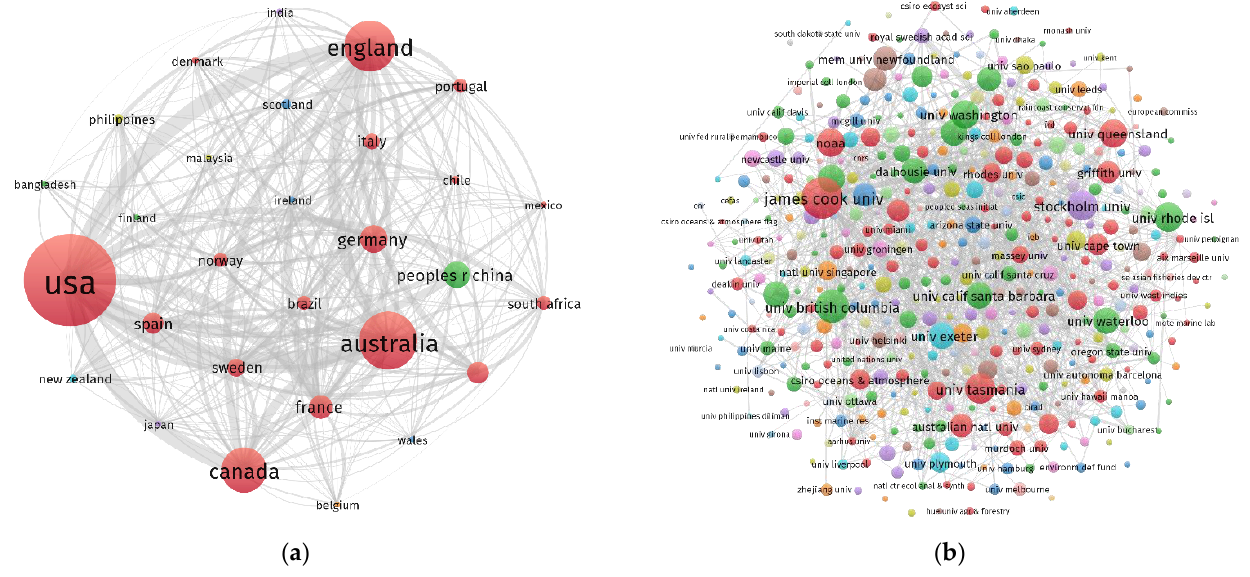
Figure 2. Co-authorship networks. ( a ) Co-authorship at a national level. ( b ) Co-authorship at an organizational level (1978–2021). Table 1. Descriptive statistics of territorial and organizational contribution to coastal governance studies